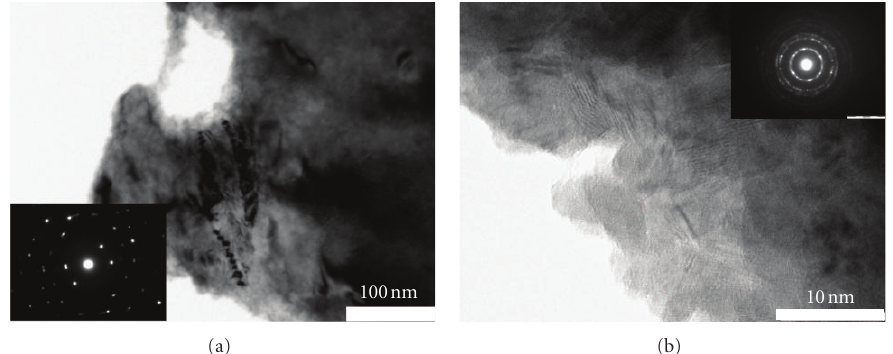
Figure 4: TEM image of spray-pyrolysis-deposited Cu-In-S with the electron di ff usion patterns (inset) on a glass substrate: (a) the major part and (b) the minor part.